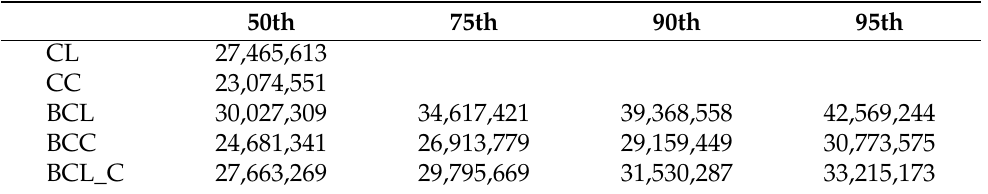
Table 17. Computed quantiles of reserves for the Table 14 applying the heat equation in one dimen- sion.